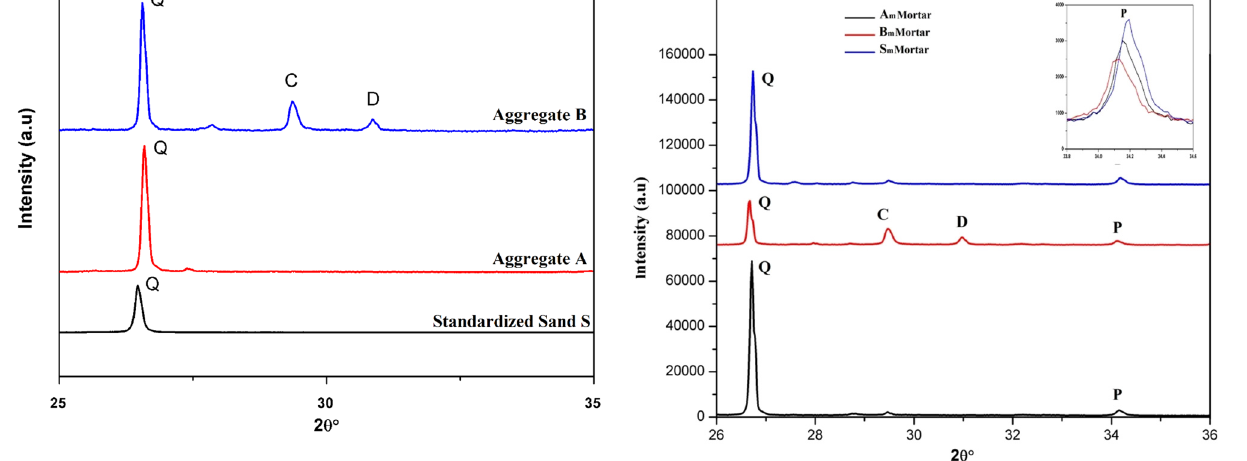
Figure 4: XRD of the aggregates A, B and standardized sand ( S ) .